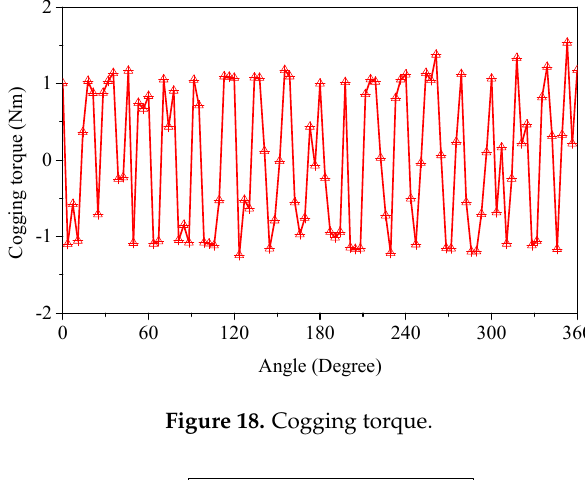
Figure 18. Cogging torque.